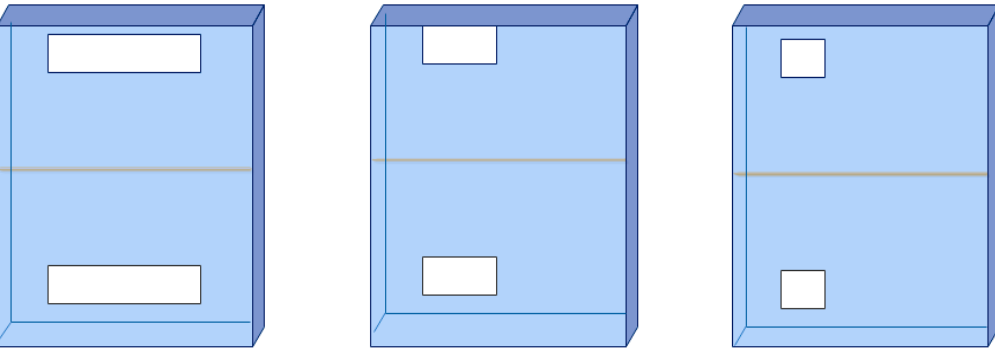
Figure 3. Three type holes on Tr-W. Table 1. Characteristics of the Tr-W. Table 2. Properties of PCM used in the present